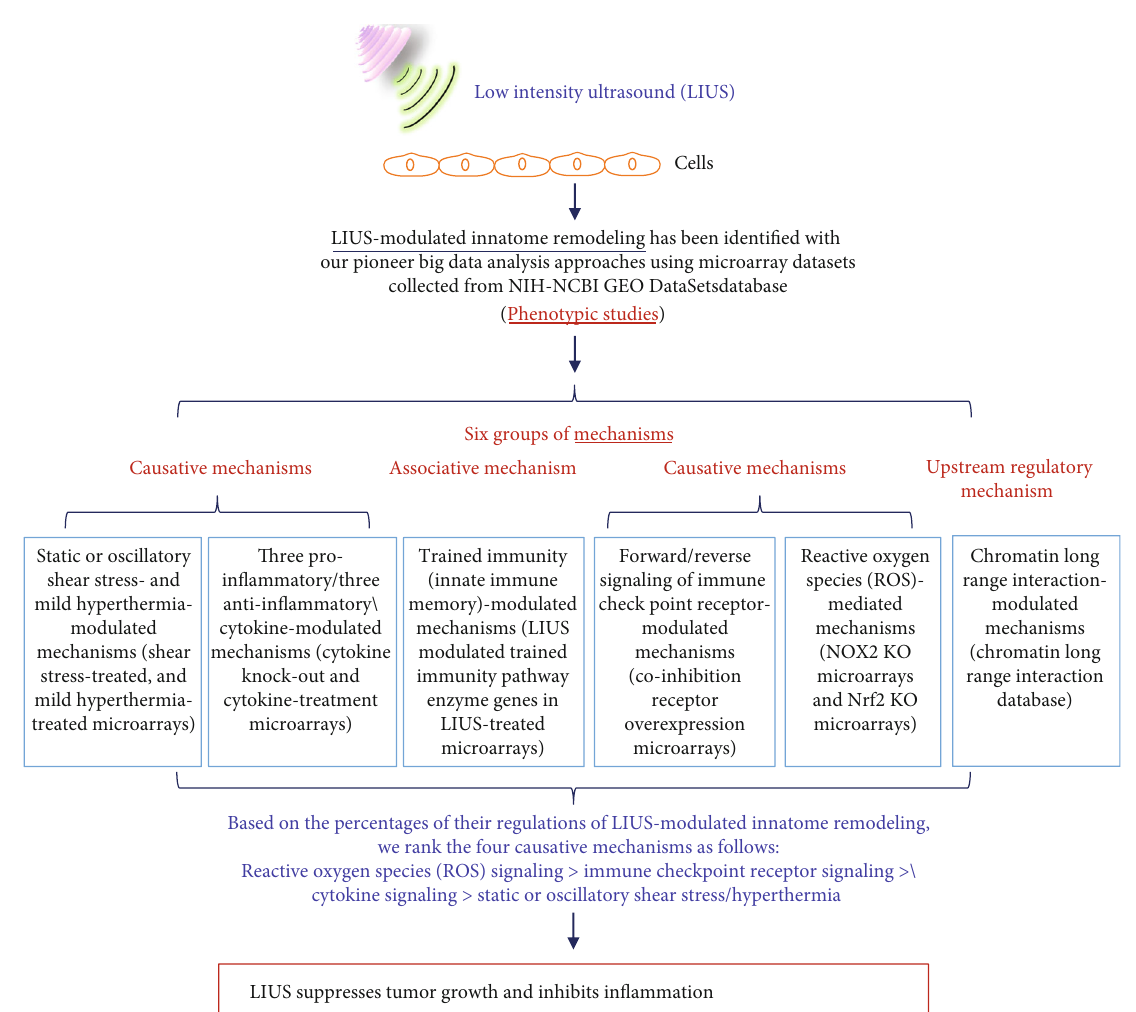
Figure 11: A new working model on LIUS-mediated cancer suppression and anti-in fl ammatory mechanisms via modulating